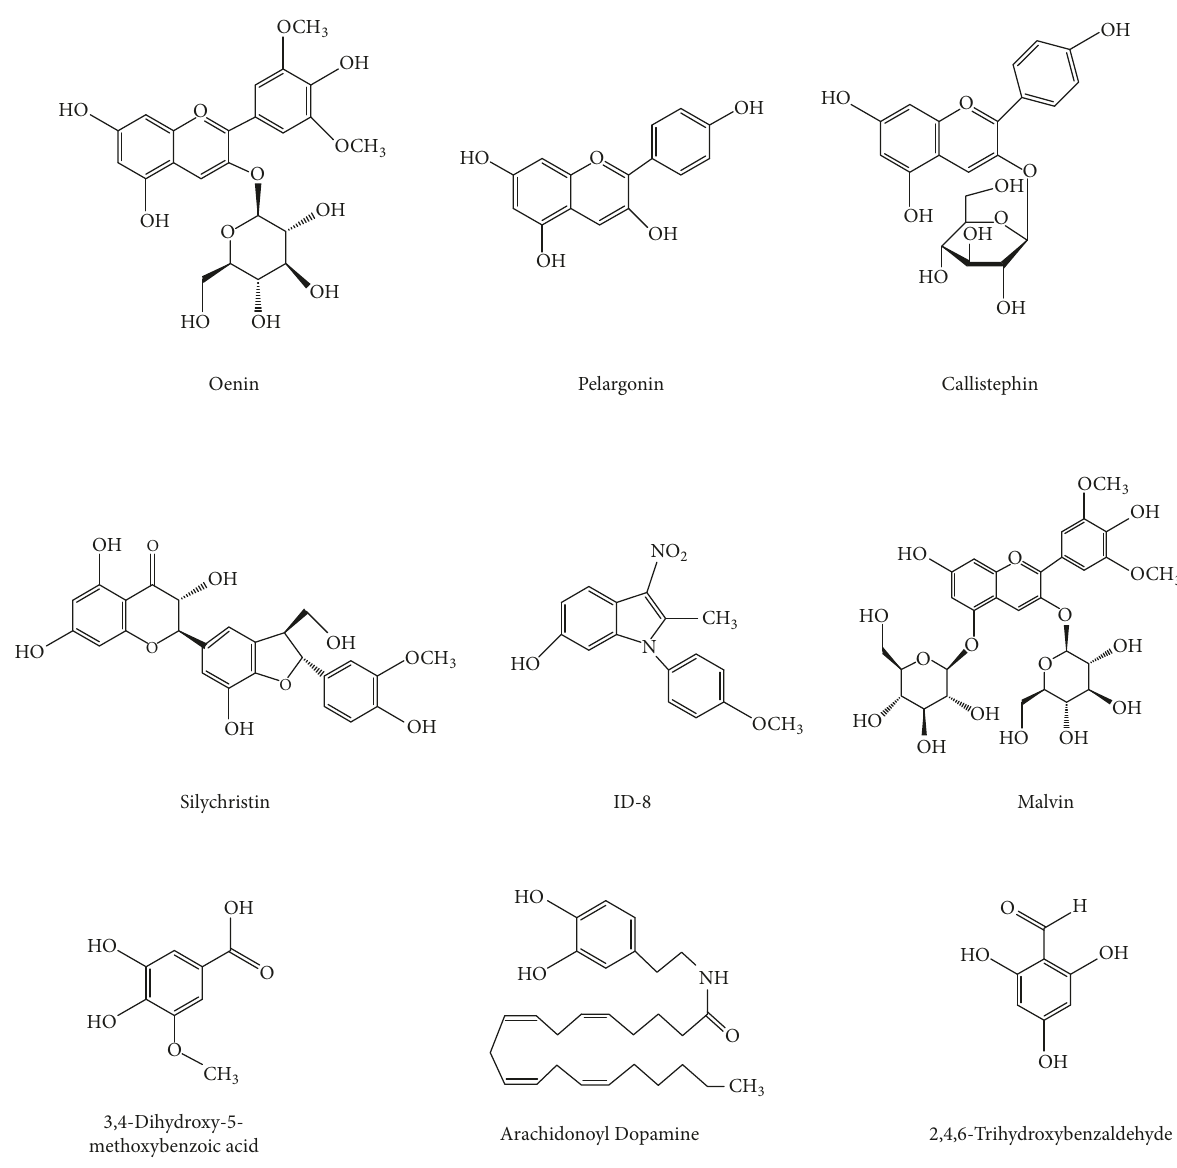
Figure 1: Molecular structures of flavonoid and phenolic substances used as antioxidant in this